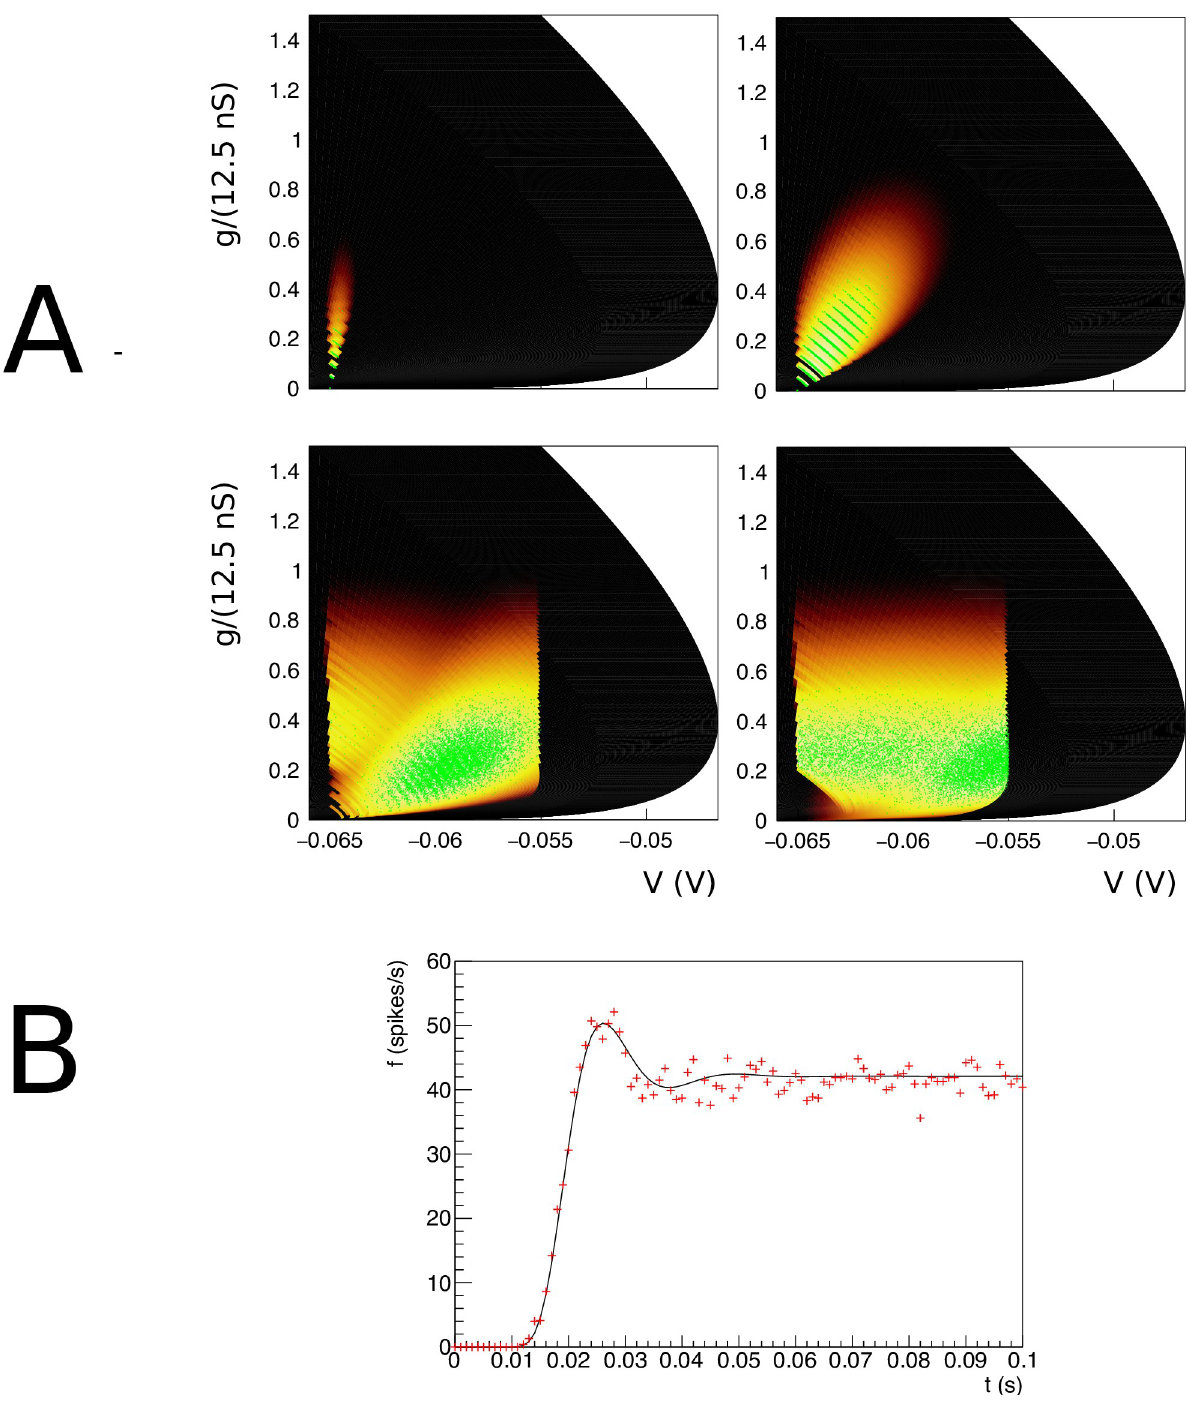
Fig 4. A: The evolution of the joint probability density function at four different points in time (1, 5, 15, 28 ms) in ( V , g ) space ( V membrane potential, g conductance) for synaptic efficacy J = 0.05, Poisson generated input spike train with rate ν = 1000 spikes per second. B: The resulting population firing rate, calculated from the fraction of mass crossing threshold per unit time as a solid black line. Spiking neuron simulation results shown by red markers. Onset and resulting firing rates are in agreement throughout. Unlike one dimensional neural models, conductance based models produce almost no